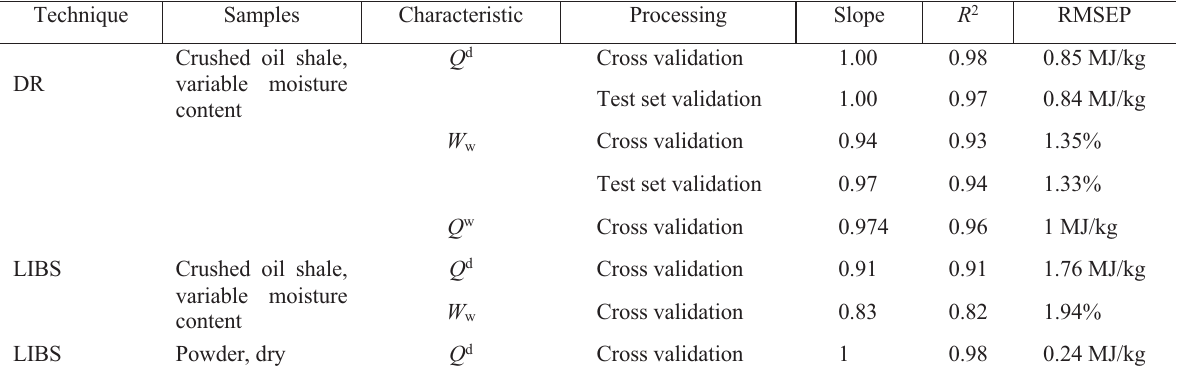
Table 2. Results of prediction of oil shale main